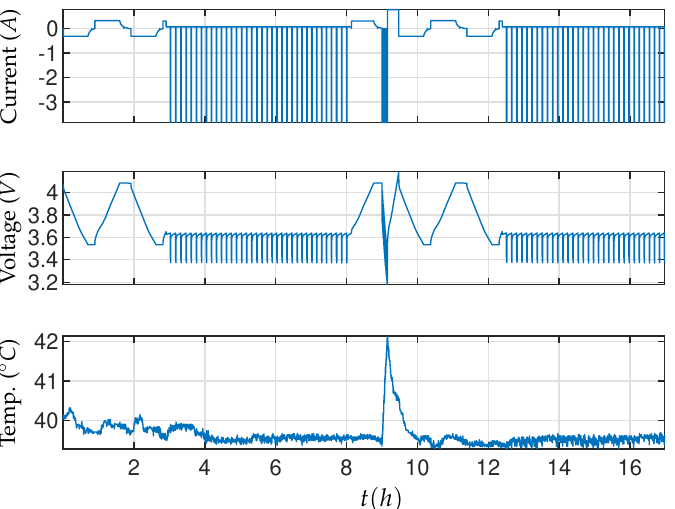
Figure 3. Current, Voltage and Temperature profiles of a section of a load cycle at high tempera- Figure 3. Current, voltage and temperature profiles of a section of a load cycle at high temperatures, tures, displaying uneven charge and discharge behaviour. displaying uneven charge and discharge behaviour.